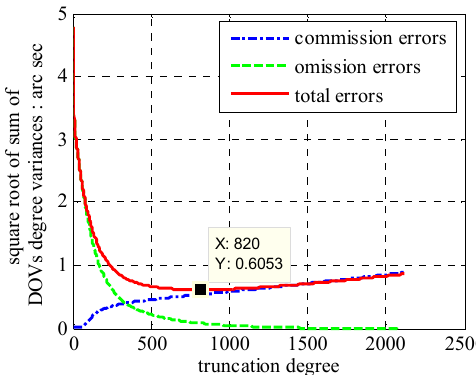
Figure 6. Errors of SHM with degree truncated to 3:2160.